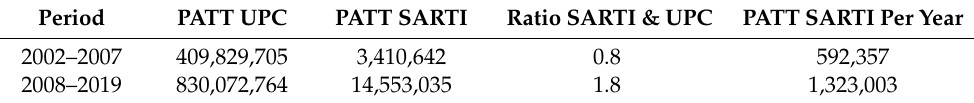
Table 12. Comparison of SARTI PATT points with those of the UPC in the period 2002–2019. Period PATT UPC PATT SARTI Ratio SARTI & UPC PATT SARTI Per Year 2002–2007 409,829,705 3,410,642 0.8